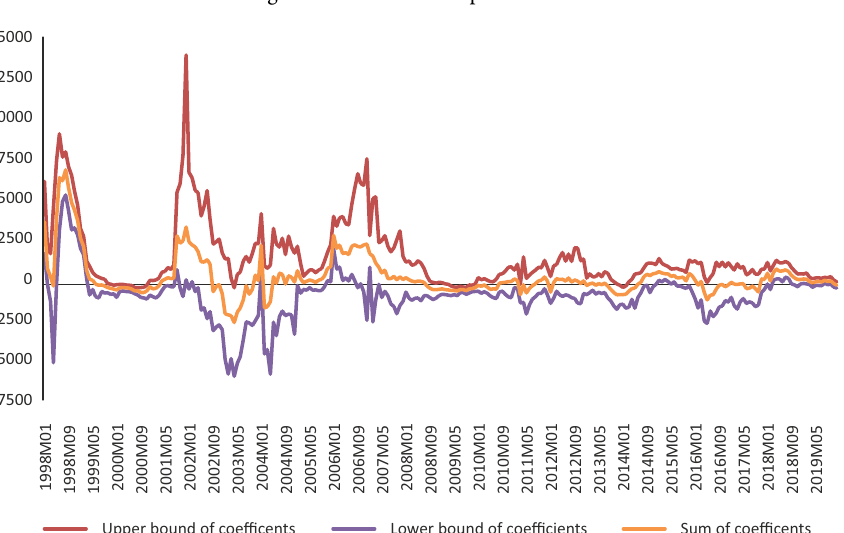
Figure 2. GPR causal impact on TEC